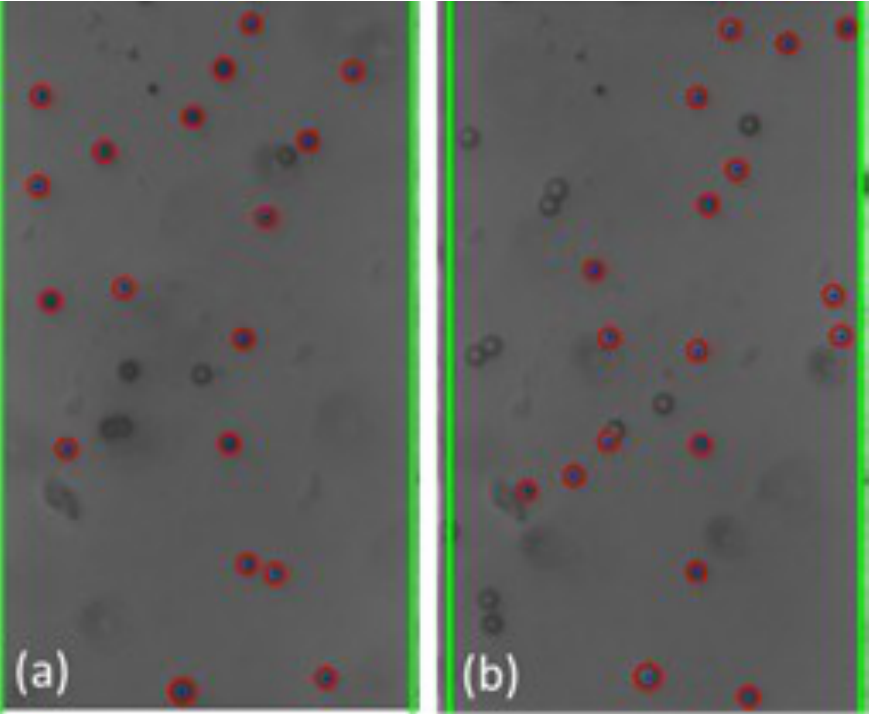
Figure 4. Examples ( a , b ) of bead detection using the Hough Circle Detector function of the OpenCV